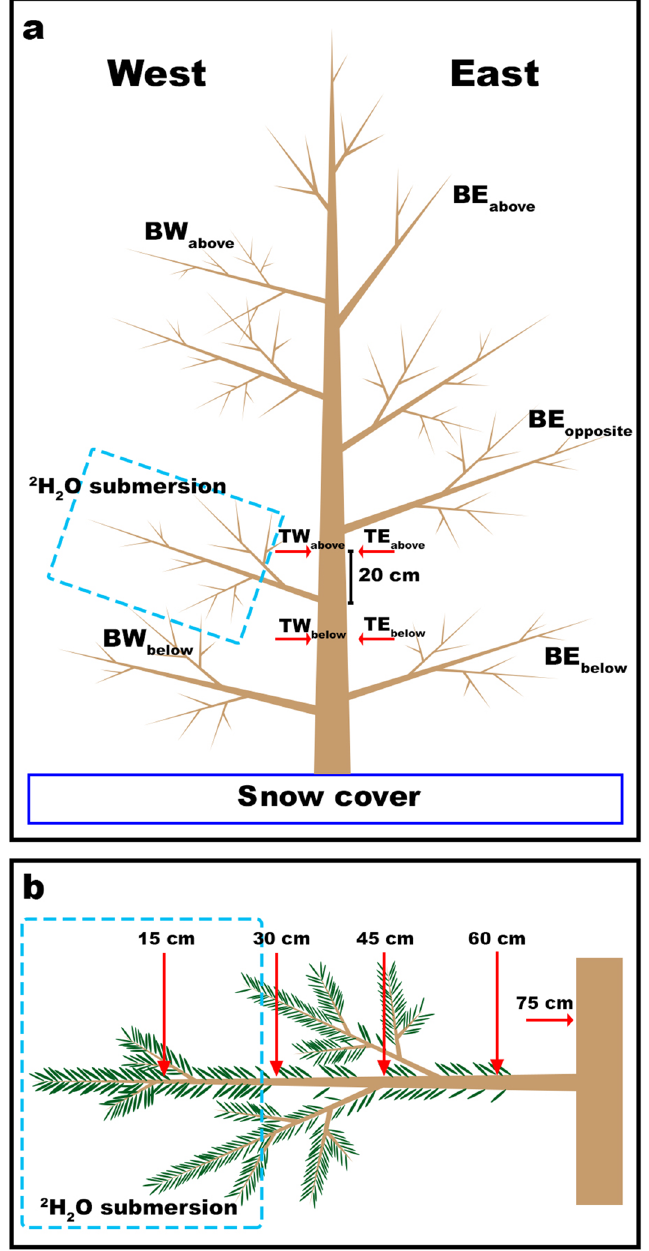
Figure 1. Experiment setups. ( a ) Setup used for the main experiment during the seasonal course (see “Seasonal course” in Methods). The image indicates the position of the bag filled with δ 2 H-labelled water (i.e., west at breast height) and the positions from which samples were collected. Trunk microcores (T) were named according to their position: 20 cm above and below the junction between labelled branch and trunk both on the west (W) and east (E) side of the trunk (i.e., TW above , TW below , TE above and TE below ). End-twigs were named according to the position of the sampling branch (B): west (W) or east (E) exposed, and above (BW above and BE above ), opposite (BW opposite and BE opposite ) and below (BW below and BE below ) compared to the position of the bag. ( b ) Setup used to test the branch water uptake in P. abies (see “Branch water uptake” in Methods). The dashed blue box indicates the position of the bag filled with labelled water. Red arrows indicate the sampling point at which microcores were extracted after bag removal (i.e.,15, 30, 45, 60 and 75 cm from the tip of the